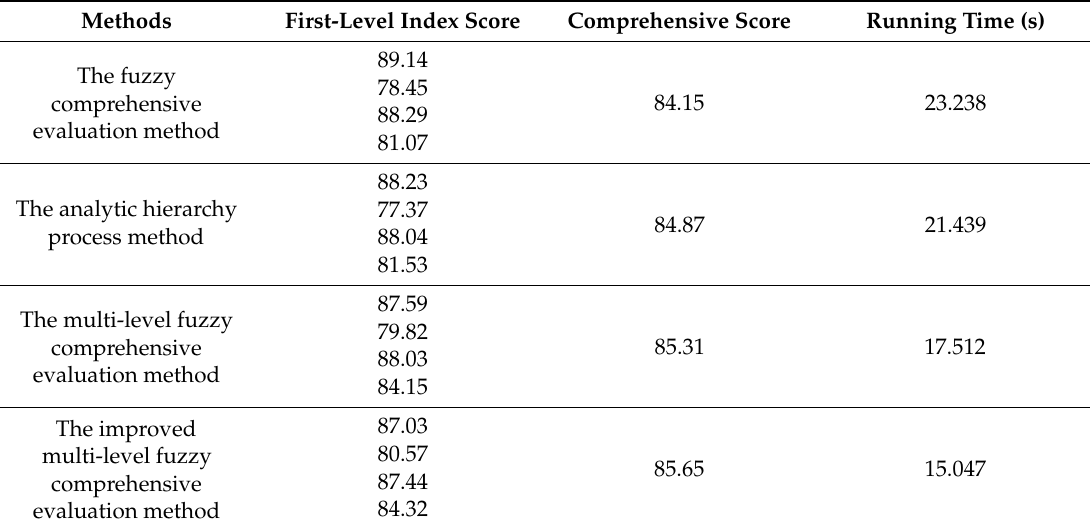
Table 4. The calculation and comparison